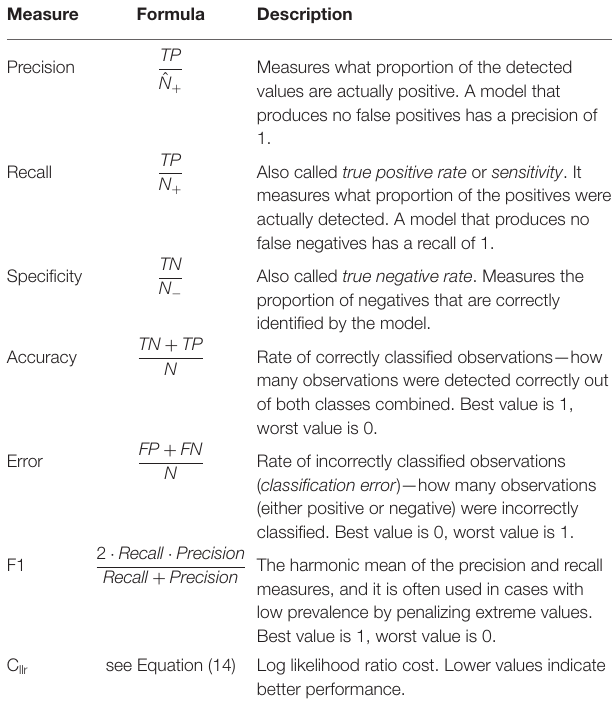
TABLE 2 | Classification performance measures and corresponding formulae and descriptions for metrics based on the confusion matrix and the C llr , a log likelihood ratio cost metric defined in Equation